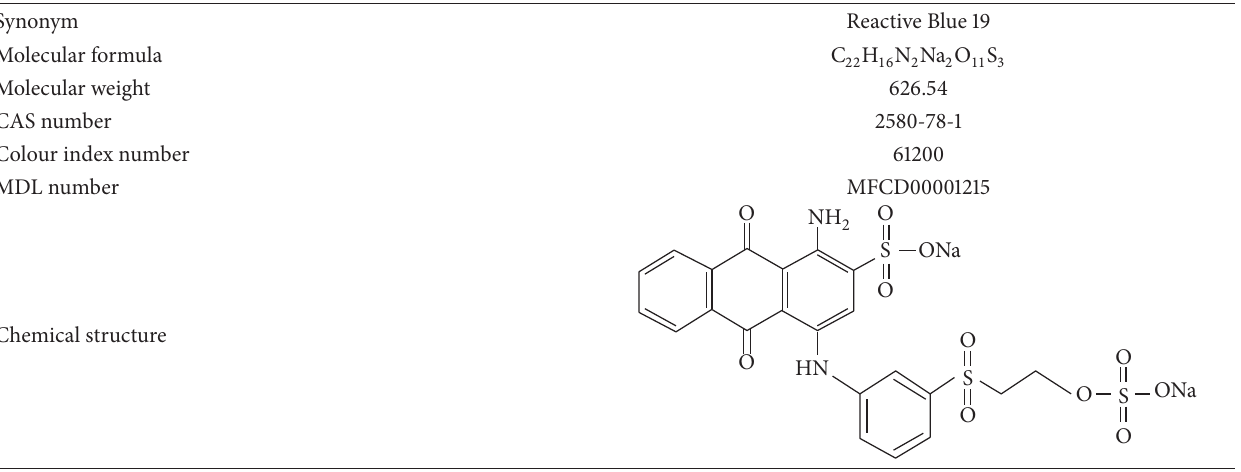
Table 1: Remazol Brilliant Blue R specification (adapted from Mahmoud et al., 2014